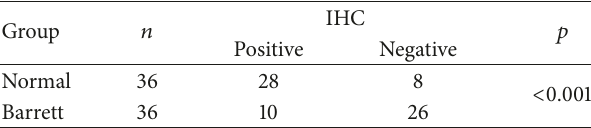
Table 5: Immunohistochemical results of